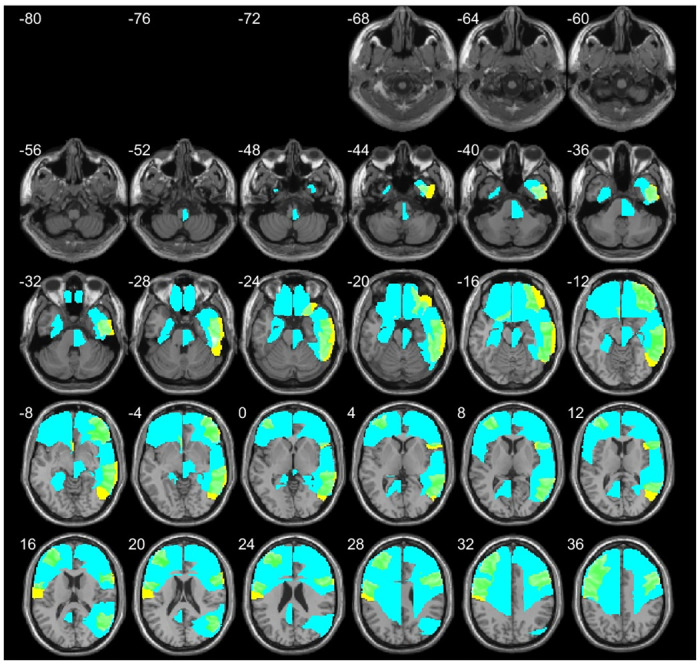
Lobes results in blue, AAL results in yellow, superposition of both results (AAL an lobes) in green.